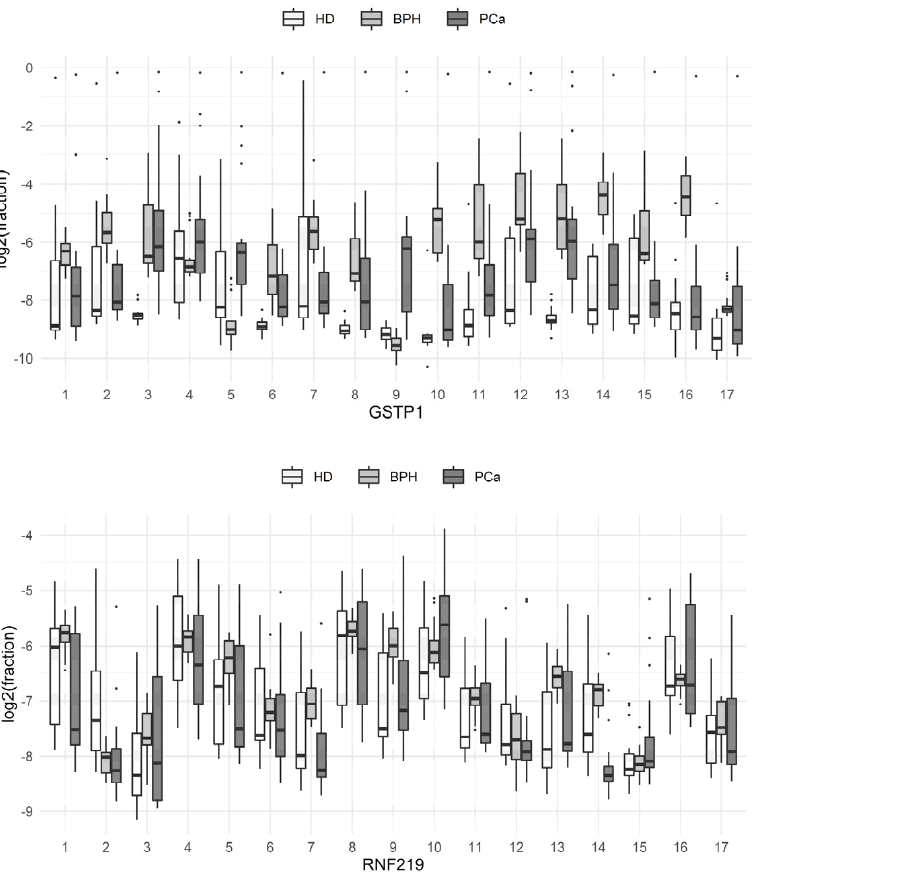
Figure 1. Comparison of the methylation levels of individual CpG dinucleotides at different positions of the studied loci of the genes of circulating blood DNA in HD, benign prostate hyperplasia (BPH), and prostate cancer (PCa) groups.